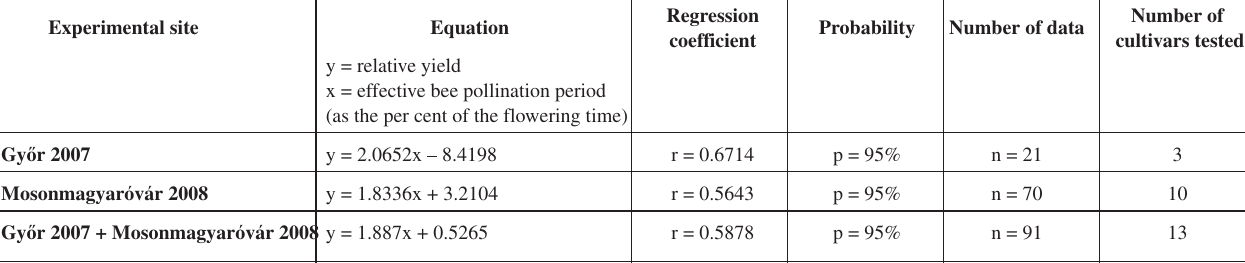
Table 4. Statistical reliability of the relationship between the effective bee pollination period and the relative yield of pear